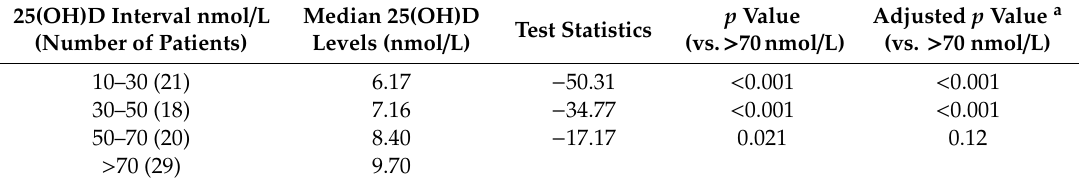
Figure A3. Scatter plot between serum 25(OH)D and mean wall thickness. Table A1. Comparison of Mean Wall Thickness across 25(OH)D intervals (Kruskal ‐ Wallis test).